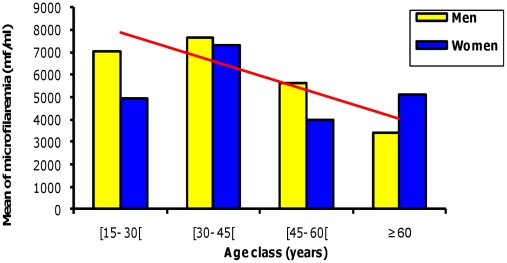
Intensity of Loa loa microfilaremia in Gabon according to age and gender.